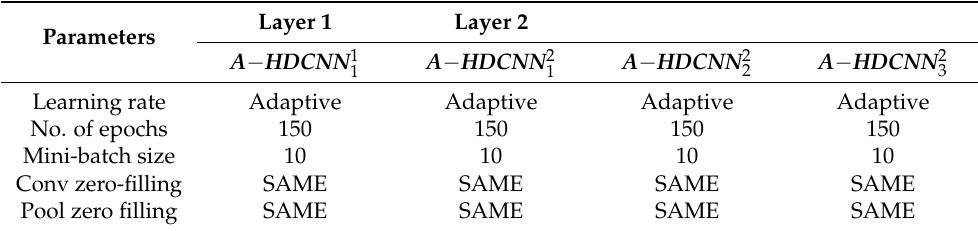
Table 4. Model initialization parameter